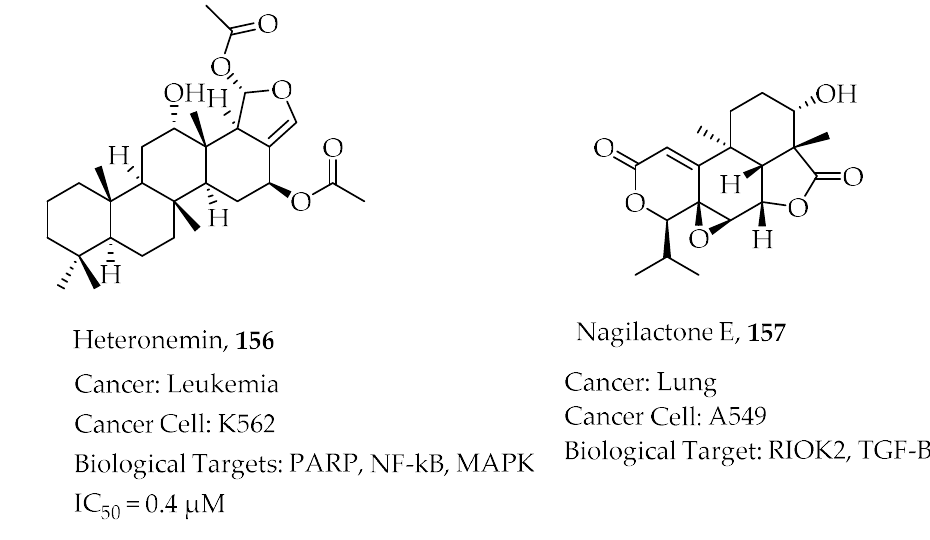
Figure 38. Structures of the sesterterpene Heteronemin and the dinorditerpenoid Nagilactone E with a summary of their biological activity towards selected cancer targets.